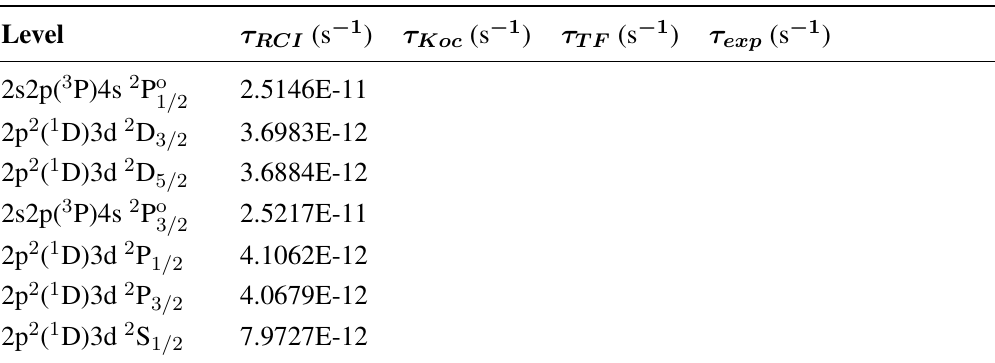
Table 3. Transition data from present RCI calculations. A is the transition rate in s − 1 ; gf is weighted oscillator strength; and I is the relative intensity (maximum 1.00) taking into rel account the branching fraction and population of upper levels as described in Section